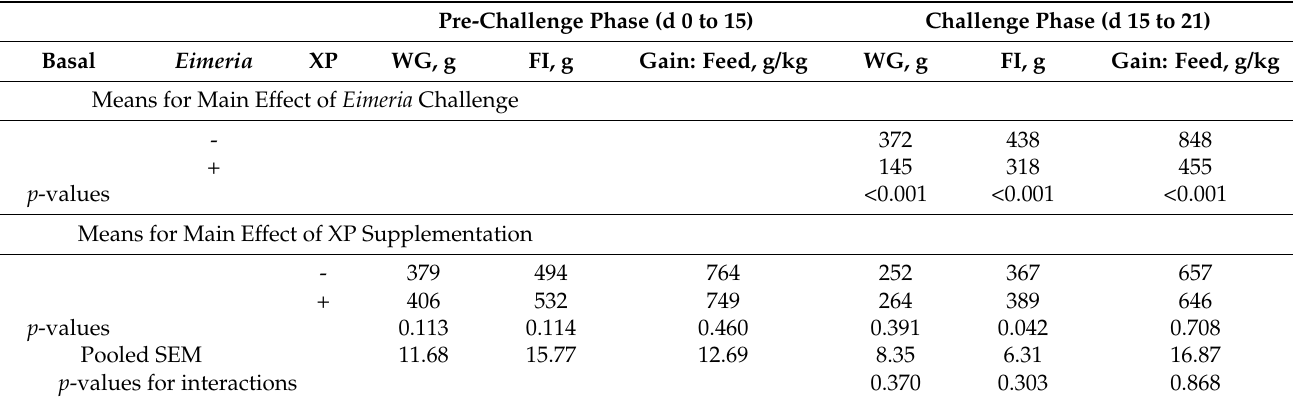
basal diets. No significant effect on lesion score was observed for XP supplementation.